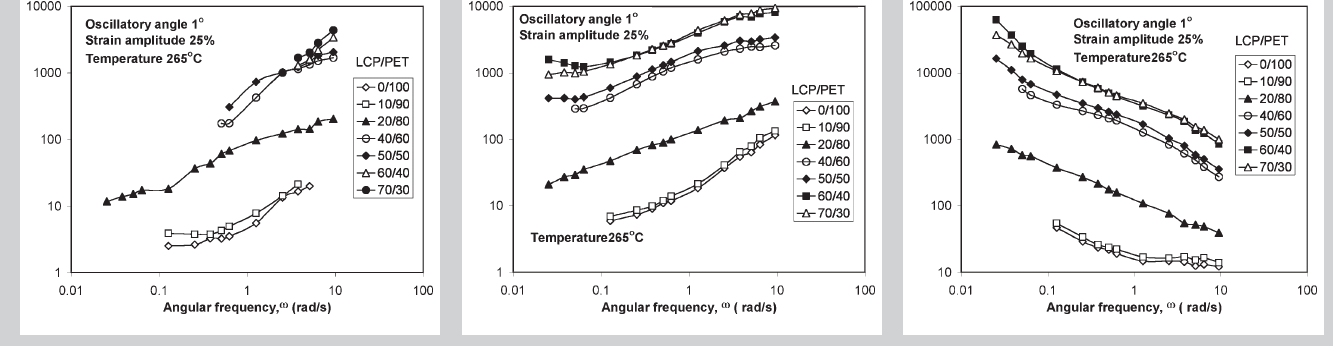
Figure 1 (left): Storage modulus, G’, versus angular frequency, w , at 265°C for different LCP/PET blends. Figure 2 (middle): Loss modulus, G’’ and angu- lar frequency, w , at 265°C for different LCP/PET blends. Figure 3 (right): Dynamic viscosity, h ’ and angular frequency, w , at 265°C for different LCP/PET